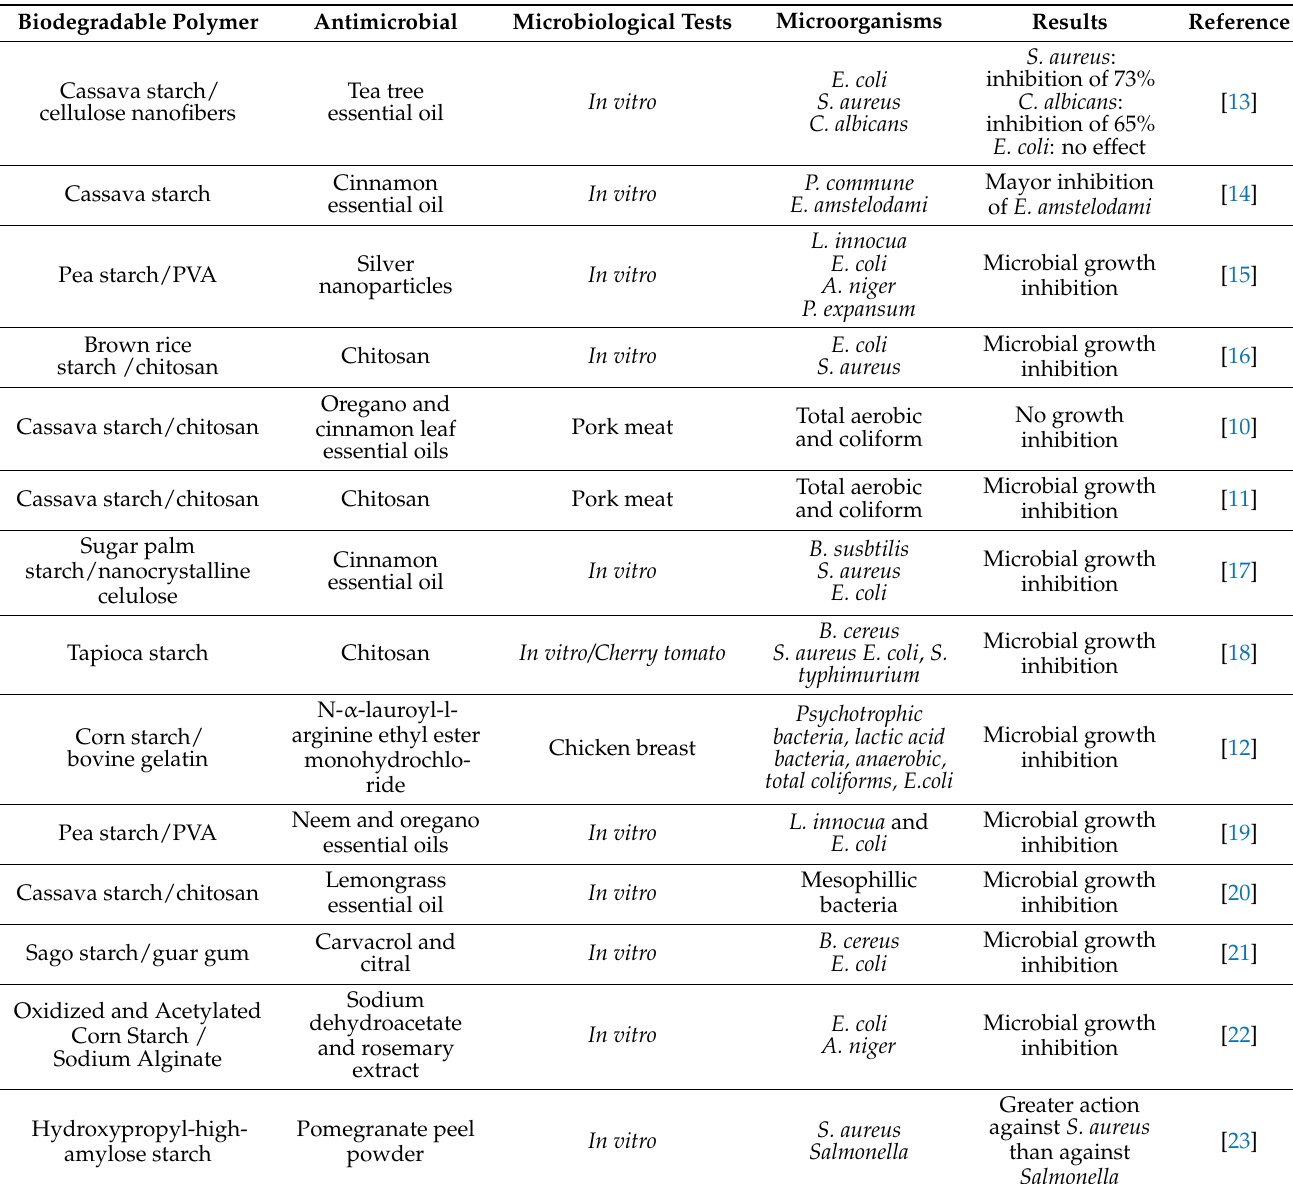
Table 1. Different studies on antimicrobial starch-based films.